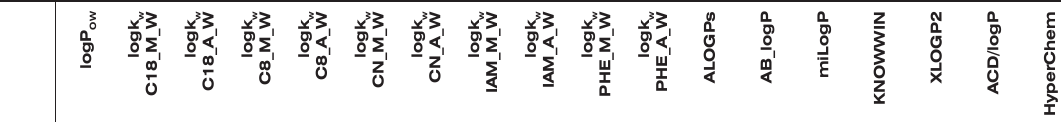
Table 3. Lower triangle correlation matrix of lipophilicity determined by experimental, chromatographic and theoretical methods (the matrix columns correspond to n=36, except the first one (n=25)).